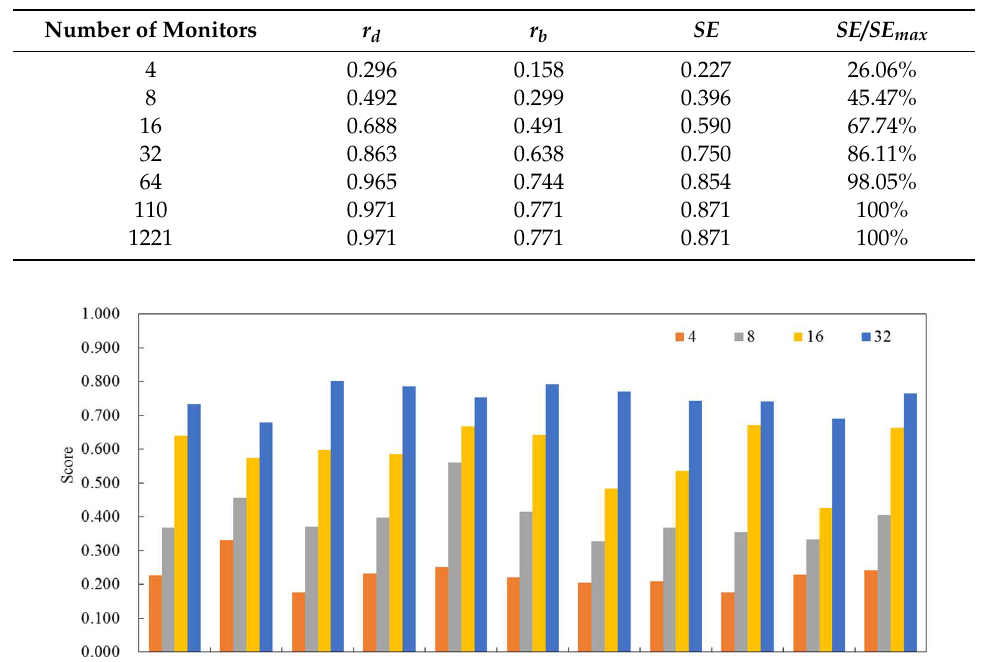
Table 2. Score performances of AQMNs with different number of monitors.